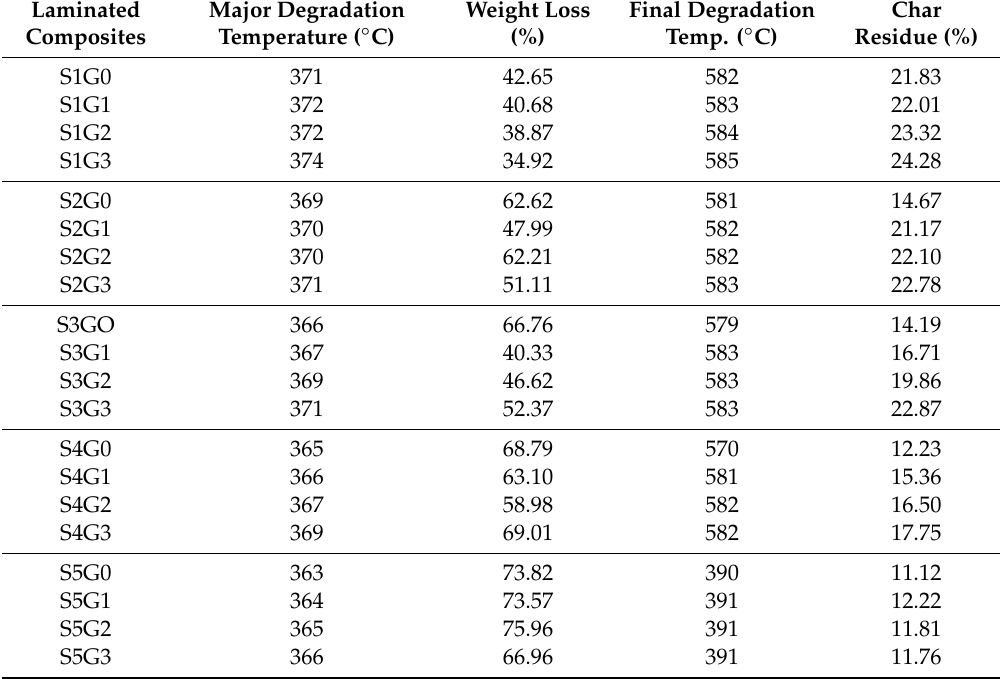
Table 2. Thermal degradation and char residue of di ff erent wt.% of Kevlar / CNS